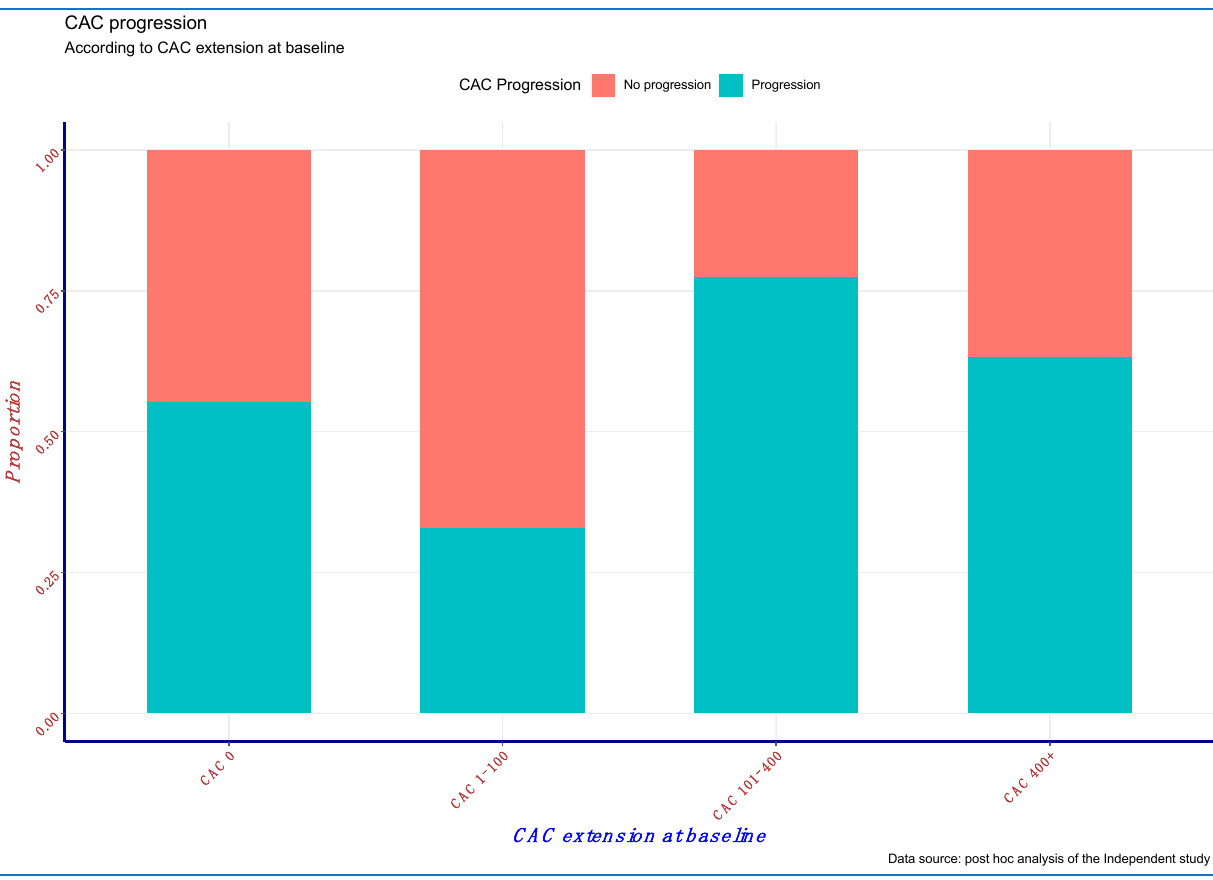
Figure 1. Coronary artery calcification (CAC) progression according to baseline CAC stratification. Table 2. Predictors of coronary artery calcification (CAC) progression by logistic regression analysis. (A) Fully adjusted model; (B) most parsimonious model selected according to a stepwise approach.